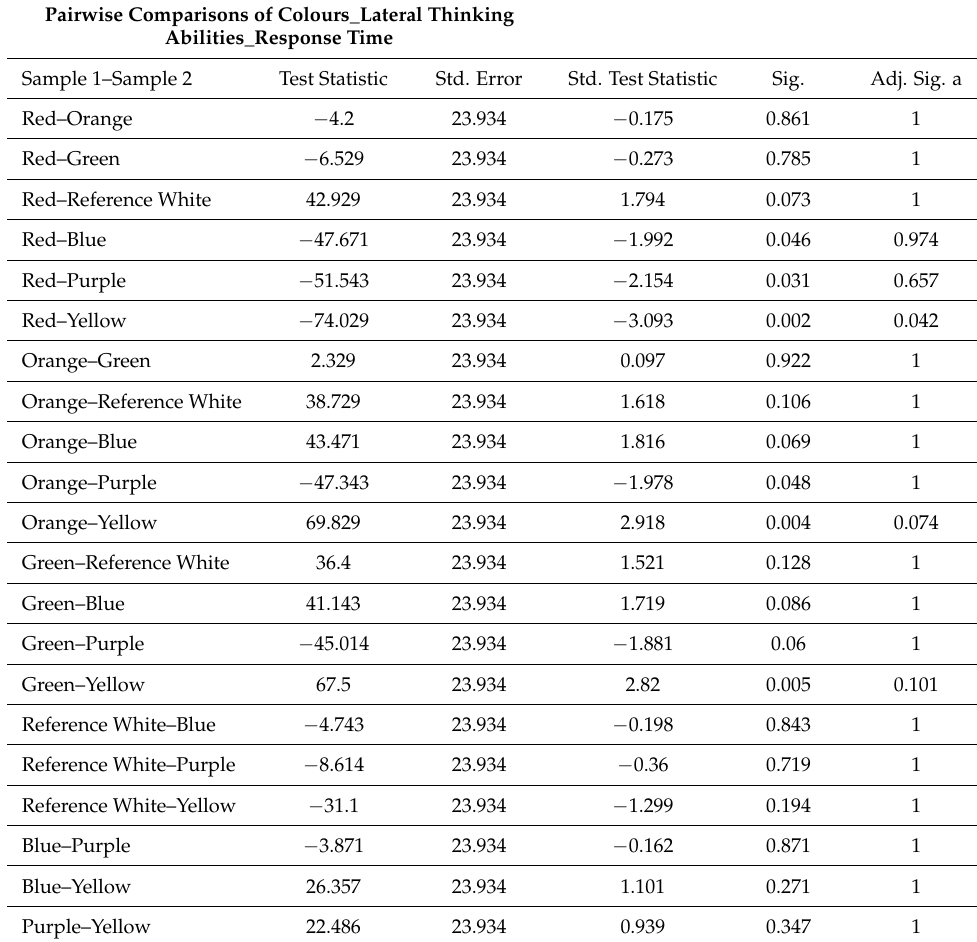
Table A15. Effects on response time (lateral thinking abilities).